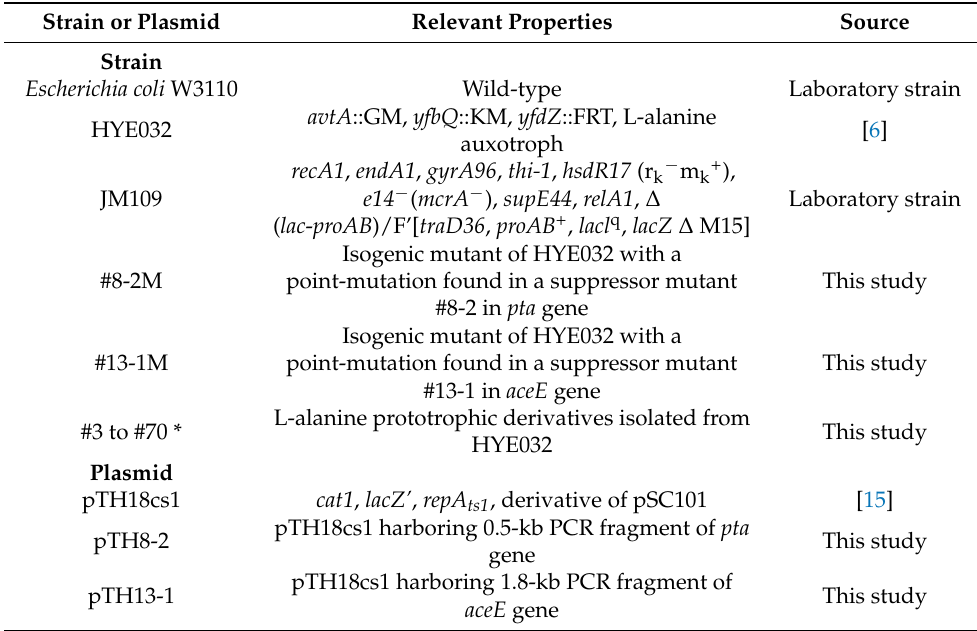
Table 1. Strains and plasmids used in this